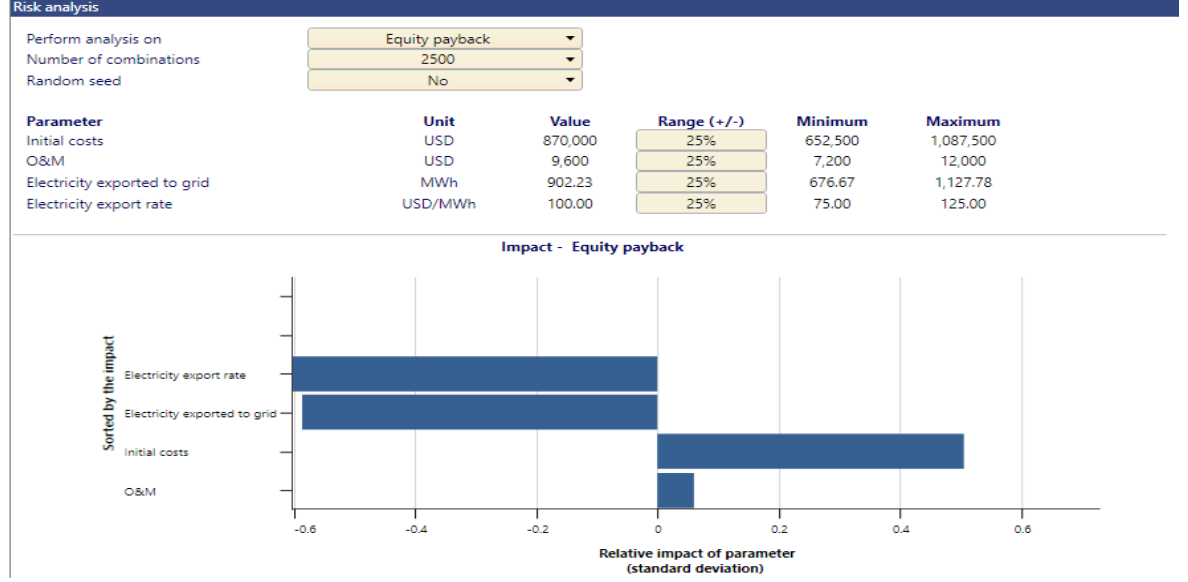
Figure 13. Risks of 650 kW solar–wind RES plant to initial cost and electricity exported to the grid for 0.1 USD/kWh.